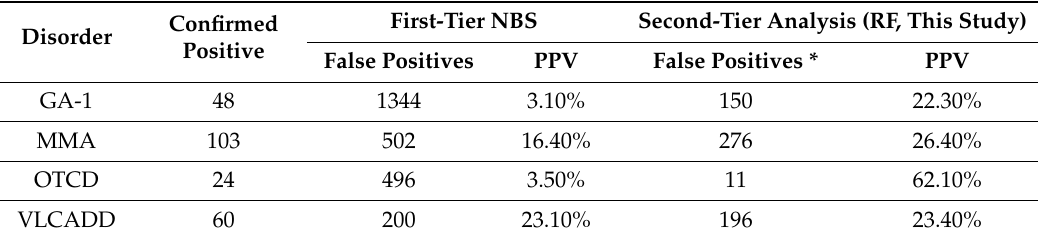
Table 1. Number of patients, false positives and PPV of first and second-tier testing (newborn screening